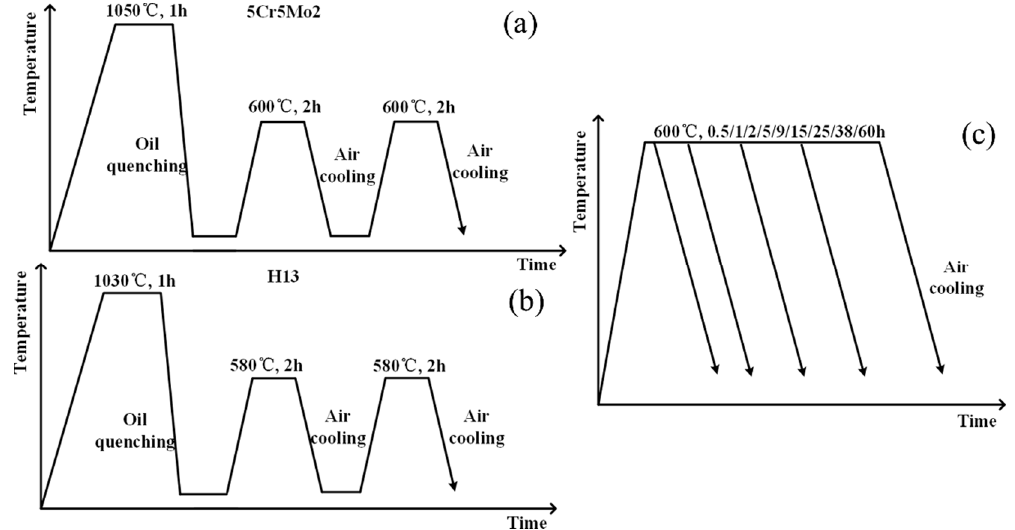
Figure 2. The pre-heat-treatment process of (a) 5Cr5Mo2 steel and (b) H13 steel; (c) The additional tempering process.